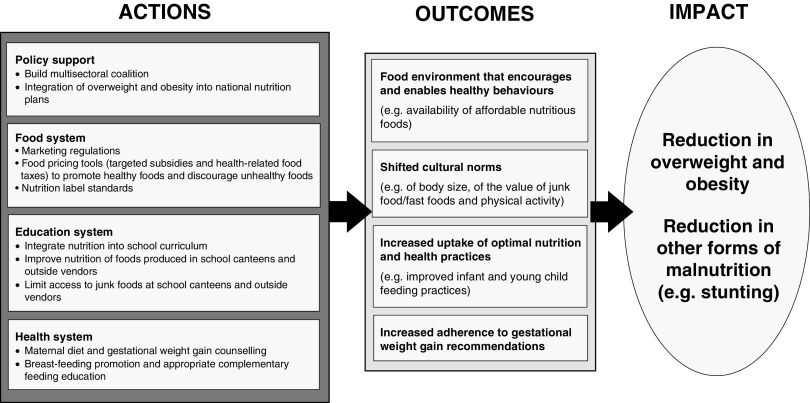
Framework illustrating how specific actions can help to achieve meaningful improvements in outcomes such as increased uptake of optimal nutrition and health practices, and how they impact overweight and obesity and other forms of malnutrition